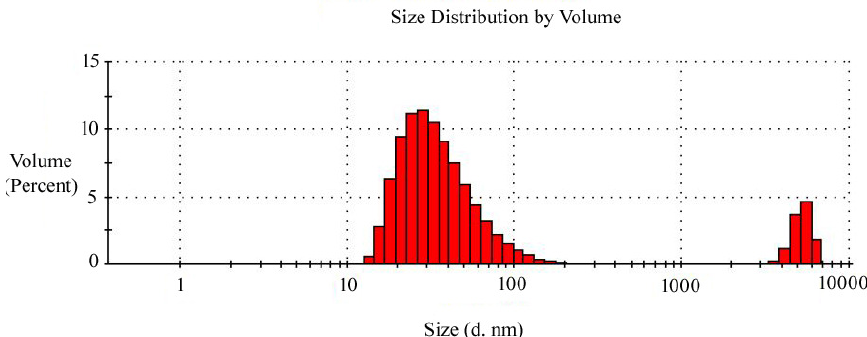
Fig. 8. DLS size distribution by volume of G. applanatum extract mediate SNPs